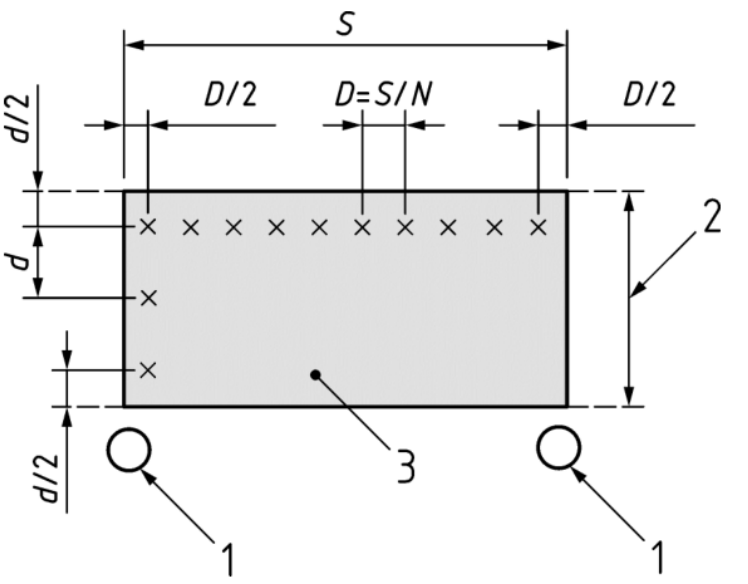
Figure 2. Calculation grid [3]: 1—poles; 2—width of relevant area; 3—field of calculation; S —lamp spacing; d —the spacing between poles in the transverse direction; D —the spacing between poles in the longitudinal direction; N —the number of calculation points in the longitudinal